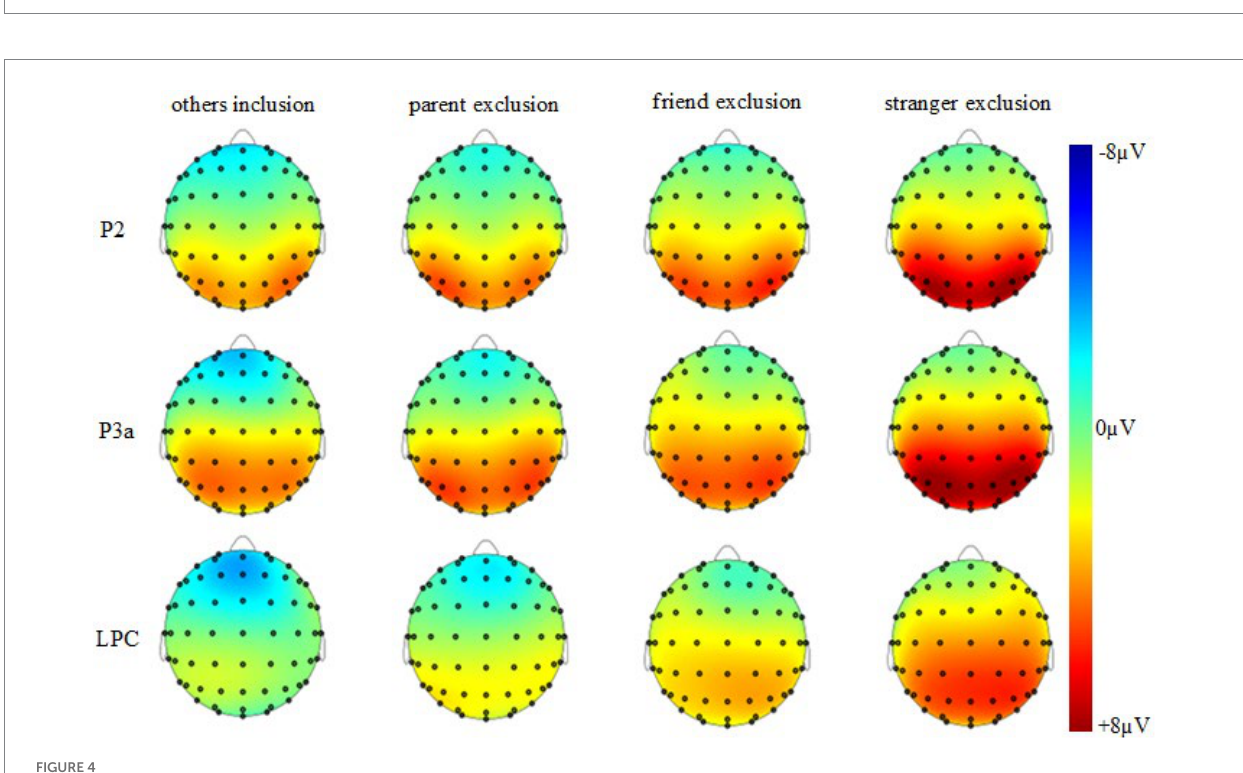
FIGURE 3 Total average ERPs waveforms of the four social priming groups.